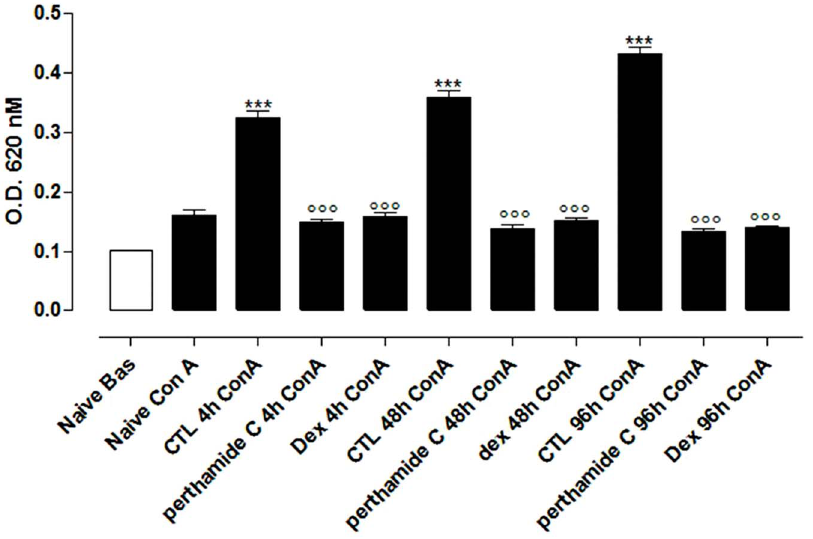
Figure 5. Proliferation assays on lymphocytes. Lymphocytes were obtained from PLN of control (vehicle) or perthamide C treated mice 4 h, 8 h or 96 h after l -carrageenan edema induction. Values are means 6 SEM of three separate experiments with n=5–6 mice. *** P , 0.001 vs Naive + Con A;